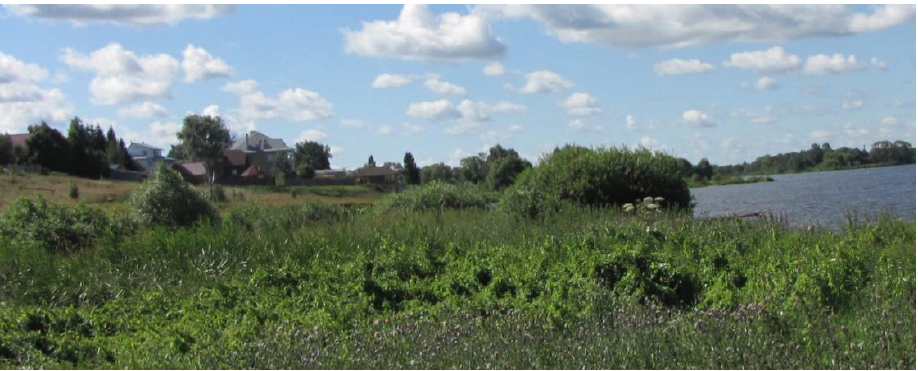
Fig. 1. Radar images of the same located area, obtained with different durations of the probing signal: 10 ns and 50 ns (from left to right).